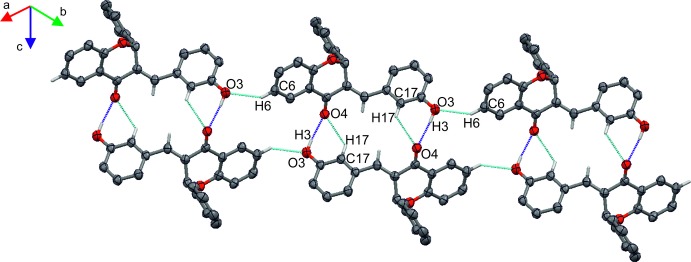
Partial packing of compound II showing the O—H⋯O (blue dotted lines) and C—H⋯O (cyan dotted lines) hydrogen-bonding network.